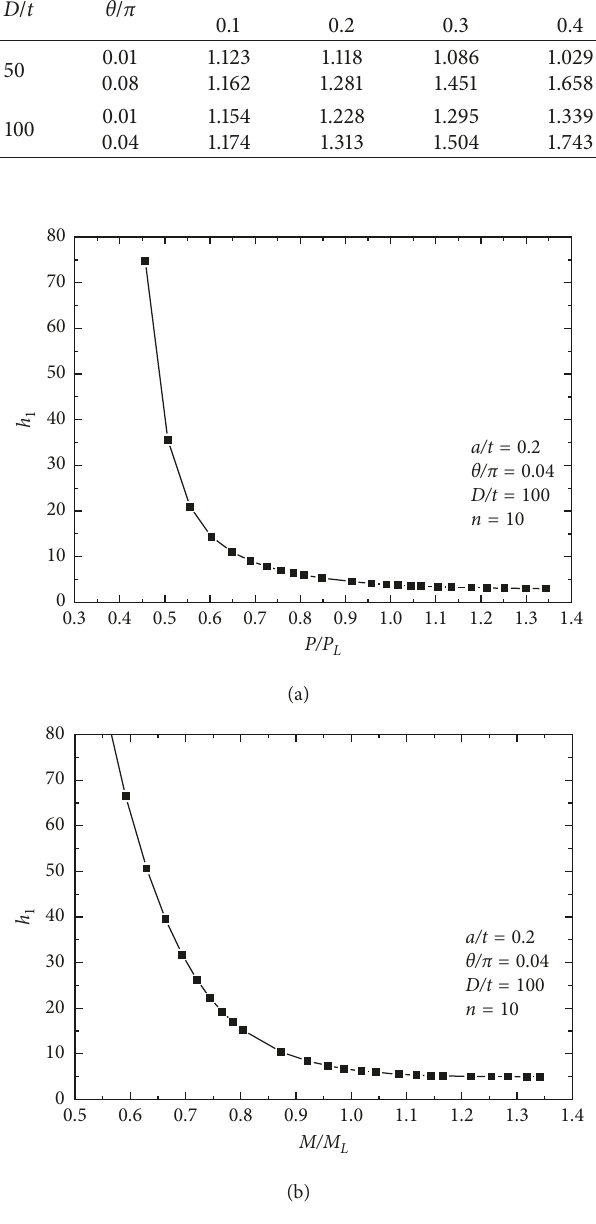
Figure 6: Variation of the FE results for h 1 with the load magnitude for a / t 0.2, θ / π 0.01, and D / t 100: (a) tension; (b) bending. (cid:31) (cid:31) (cid:31)